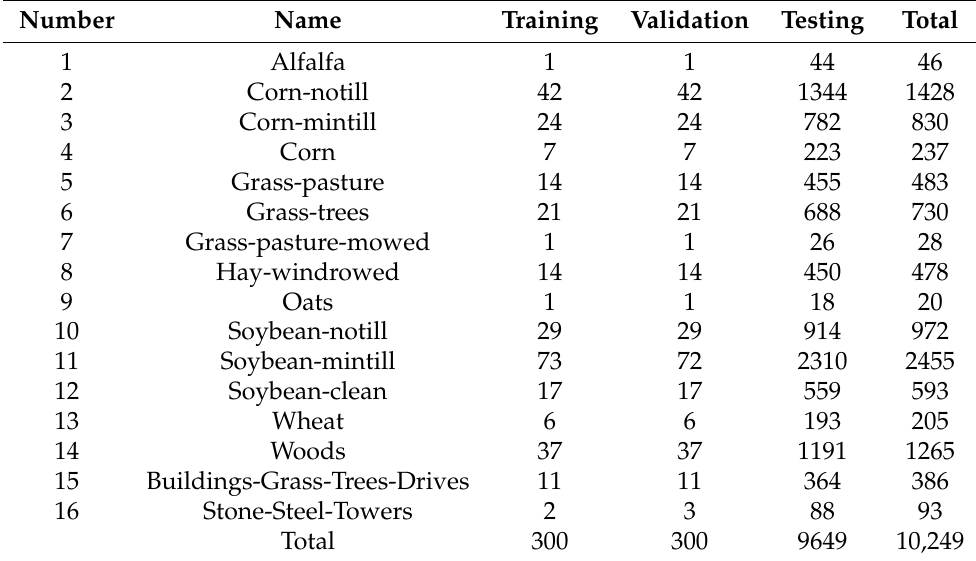
Table 1. Training, validation, and testing sample numbers in Indian Pines.